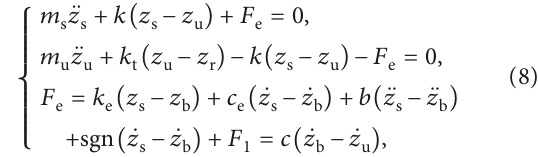
Figure 8: Quarter car model of the vehicle suspension involving the hydraulic electric